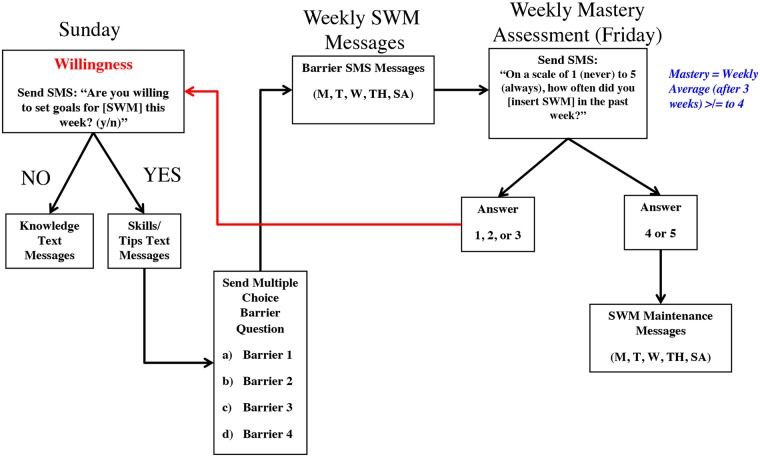
Text message (SMS) logic and flow of tailored messages.SMS, short message service.